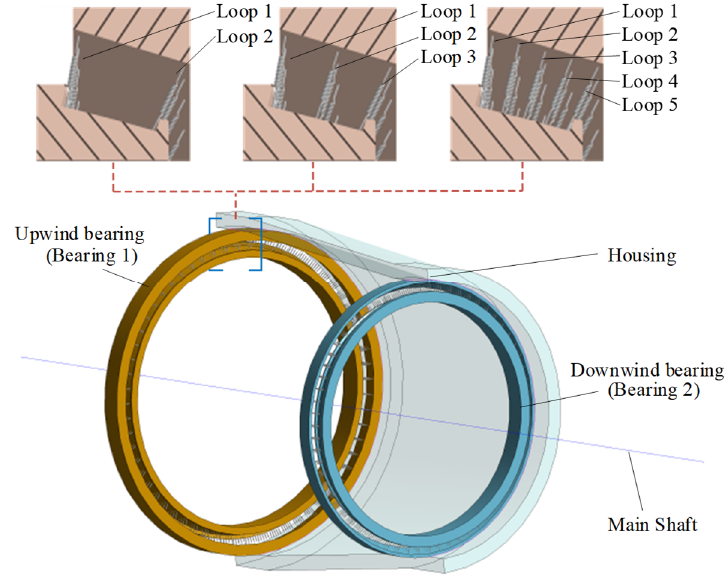
Figure 8. FE model of shaft system with different quantities of replacement springs.